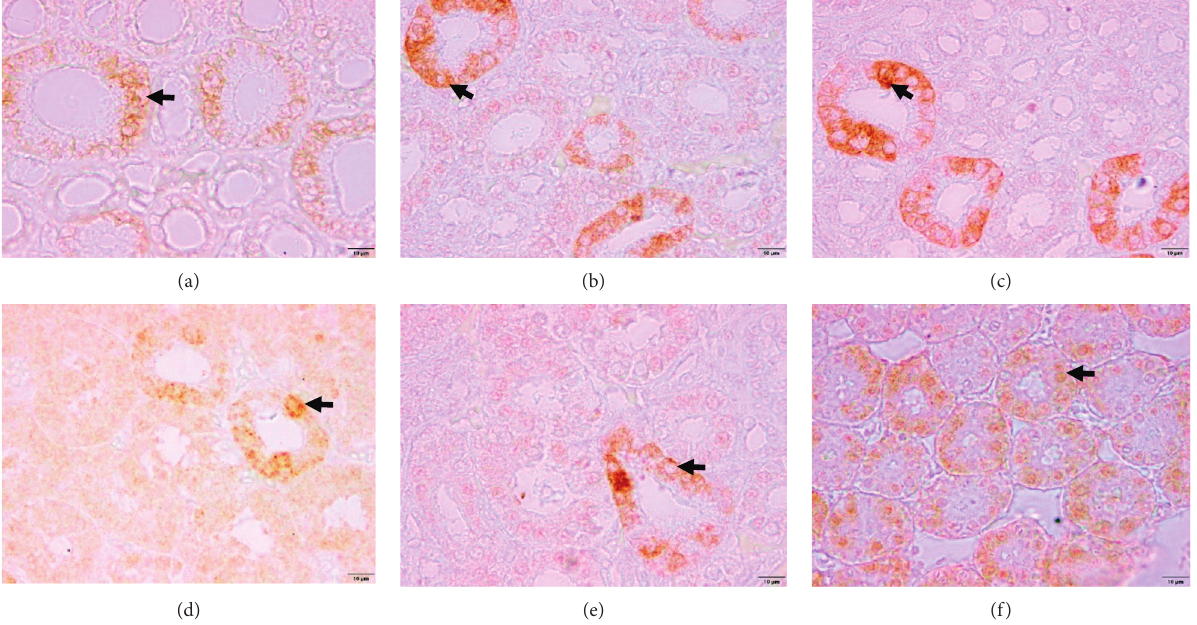
Figure 2: The results of the staining of aquaporin 2 on tissue in chicken kidneys. (a) HS +0, AQP2 positive in tubule cells (light brown). (b) HS+50, AQP2 positive in tubule cells (brown). (c) HS+100, AQP2 positive in tubule cells (dark brown). (d) nHS+0, AQP2 positive in tubule cells (light brown). (e) nHS+50, AQP2 positive in tubule cells (light brown). (f) nHS+100, AQP2 positive in tubule cells (light